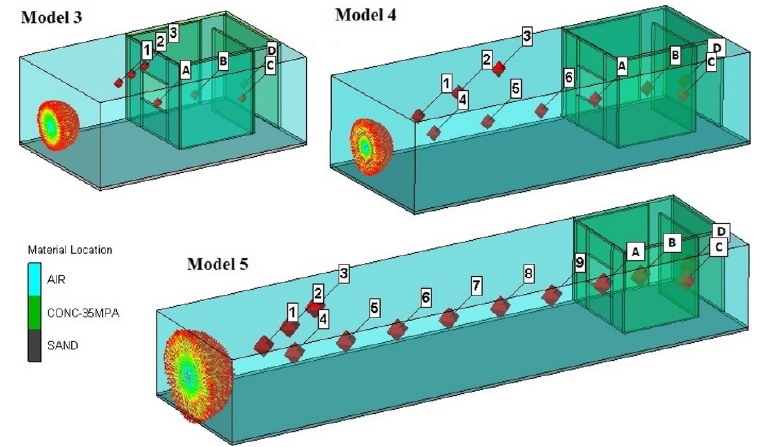
Figure 7. Models 3, 4 and 5 discretized on